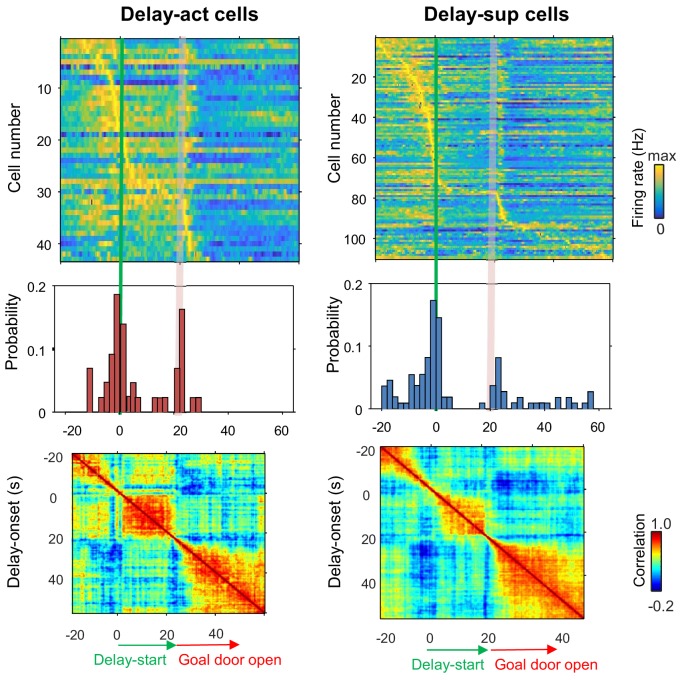
Population coding of long delay in the inhibitory CA1 cells.Temporal patterns of firing rates in inhibitory CA1 delay-active and delay-suppressed cells during delay. Top, color-coded temporal firing patterns. Neurons were ordered by the time of their peak firing rates. Middle, temporal distribution of the peak firing rates of the neurons. Green lines indicate delay-onset. Pale red lines indicate expected delay-offset. Bottom, correlation matrix of population vectors as a function of time for CA1 delay-active and delay-suppressed cells.